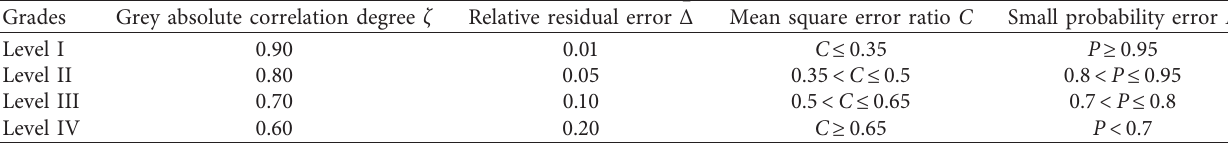
Table 1: The accuracy check level of GM (1: 1)